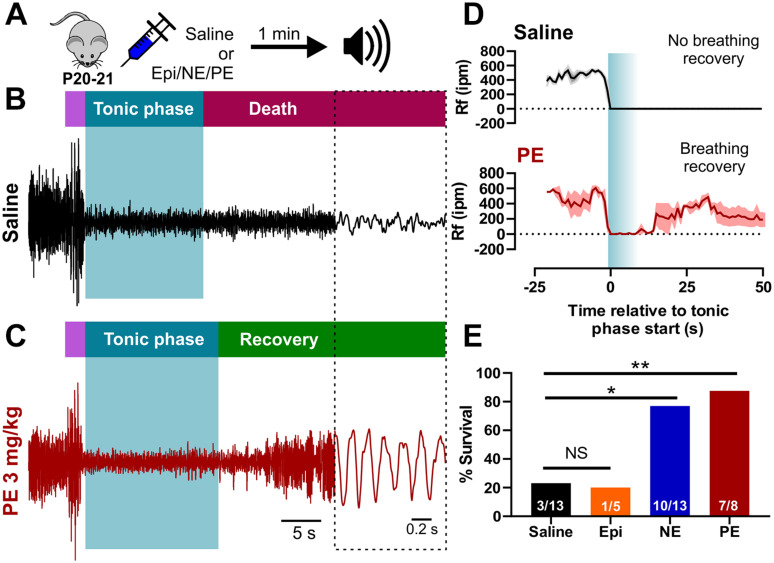
Acute activation of alpha-1 adrenergic receptors rescues seizure-induced sudden death in P20-21 D/+ mice. (A) P20-21 D/+ mice were injected (i.p.) with saline, 2 mg/kg epinephrine (Epi), 2 mg/kg norepinephrine (NE), or 3 mg/kg phenylephrine (PE) 1 min before stimulating an audiogenic seizure. Example plethysmography recordings of breathing during audiogenic seizures in P20-21 D/+ mice injected with saline control [black; (B)] or PE [red; (C)] 1 min before acoustic stimulation. In the saline-treated mouse, breathing ceased during the tonic phase and never recovered leading to death. In the PE-treated mouse, breathing also ceased during the tonic phase but recovered and the mouse survived. (D) Average breathing rates (Rf ipm) binned every second for saline-treated (black, n = 5) and PE-treated (n = 3, red) P20-21 D/+ mice. (E) Bar chart of survival of control saline-treated mice (black; n = 13), Epi-treated mice (orange; n = 5), NE-treated mice (blue; n = 13), and PE-treated mice (red; n = 8) reveals significantly elevated rates of survival in NE (*P < 0.05) and PE-treated (**P < 0.01) mice. Statistical comparisons made using a one-sided Fisher’s exact test.